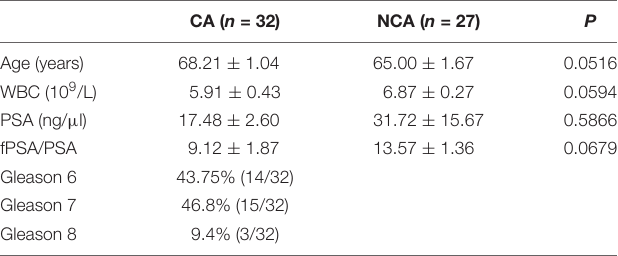
TABLE 1 | The clinical characteristics and pathological parameters of the two groups.